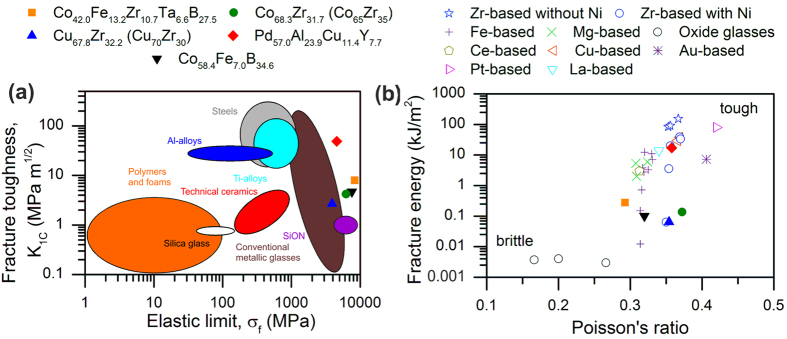
Experimental validation reveals extraordinary damage tolerance for the metallic glasses studied in this work.(a) The fracture strength of the thin film metallic glasses studied in this work is close to the ideal strength of the material. The Pd57.0Al23.9Cu11.4Y7.7 thin film metallic glass is shown to exhibit high damage tolerance. (b) The Poisson ratio cannot gauge the chemical origin of the rapid evolution from brittle to tough behaviour. Literature data for the Mg-based, Ce-based and La-based1842, Fe-based40, oxide543, Zr-based1112, Cu-based641, Pt-based3, Au-based18 and Ge-Se chalcogenide glasses16 are presented.